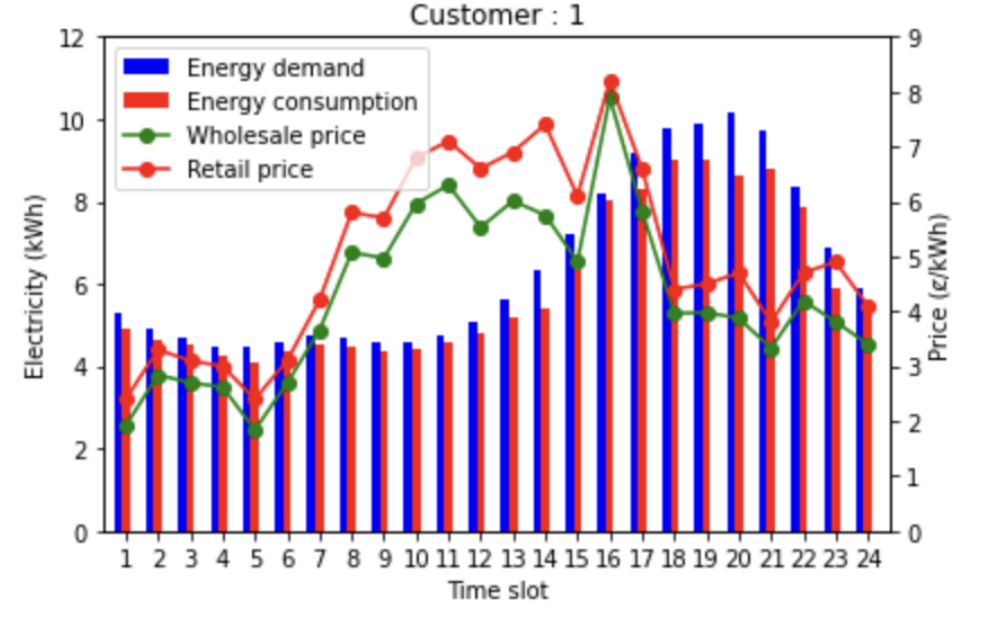
Figure 13. Energy demand and consumption with optimal retail price for customer 1.